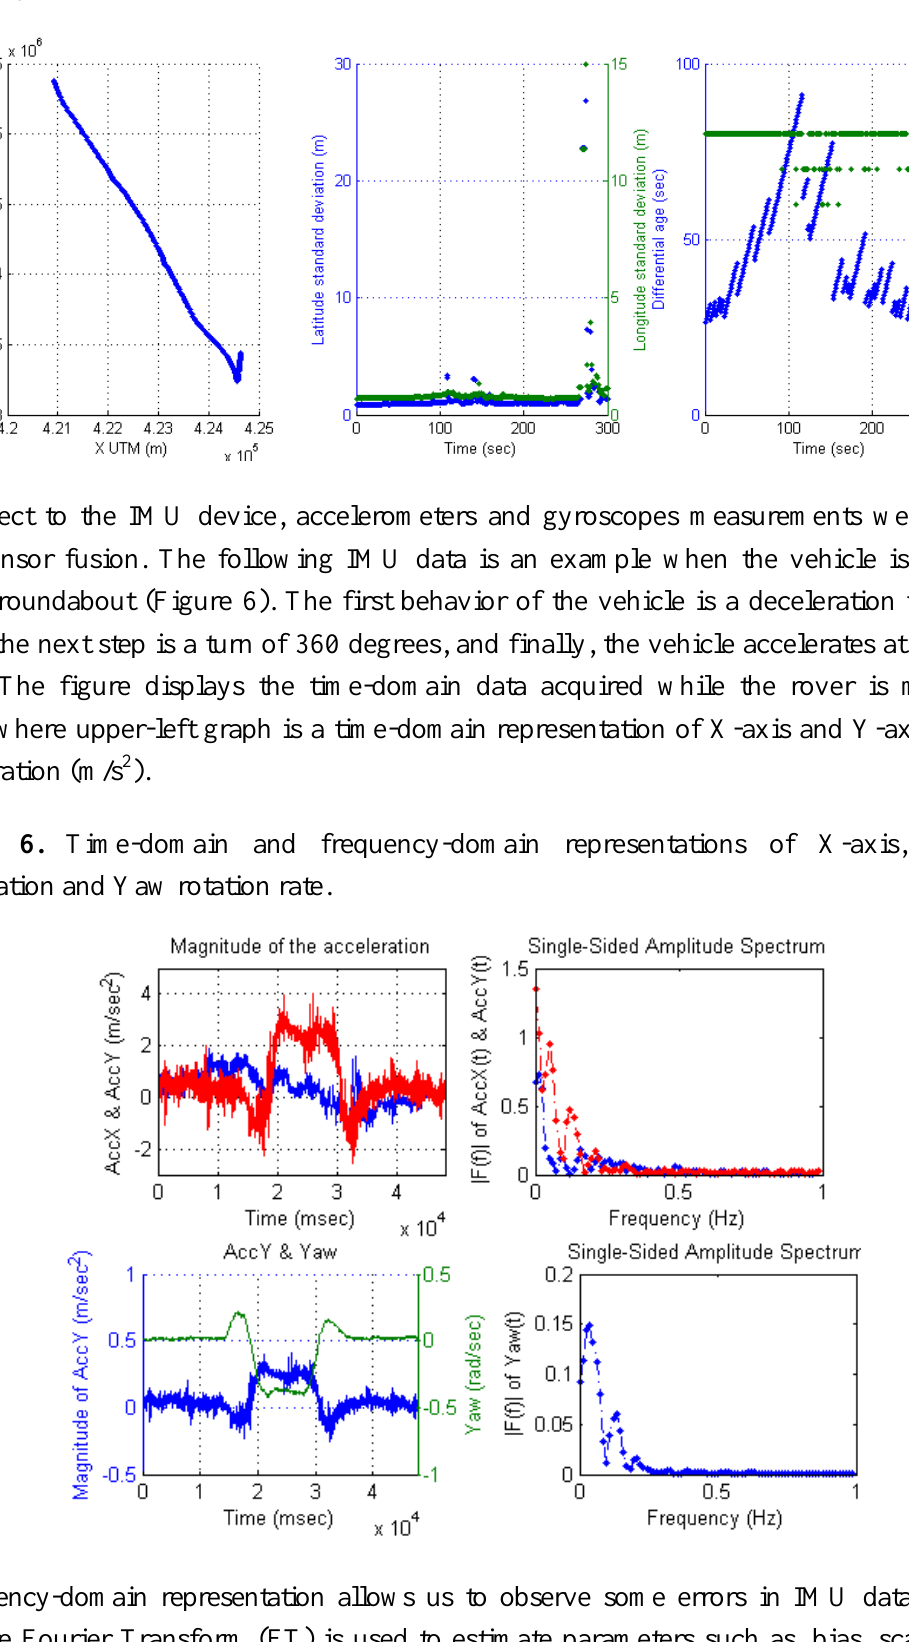
Figure 5. Effect of the high value of the correction age at 110 s and the passing under a motorway at the end of experiment.